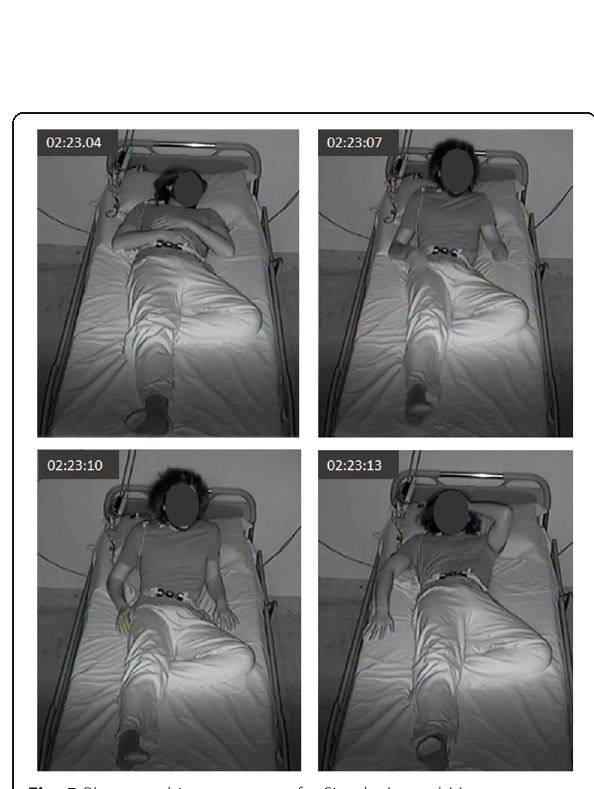
Fig. 5 Photographic sequences of a Simple Arousal Movement (SAM), pattern IC: head flexion and partial trunk